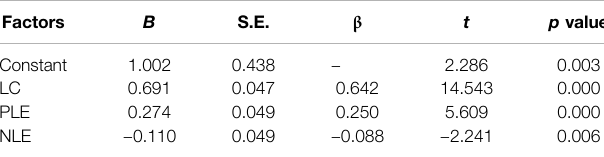
TABLE 15 | Factors included in the training multiple regression model (75% of